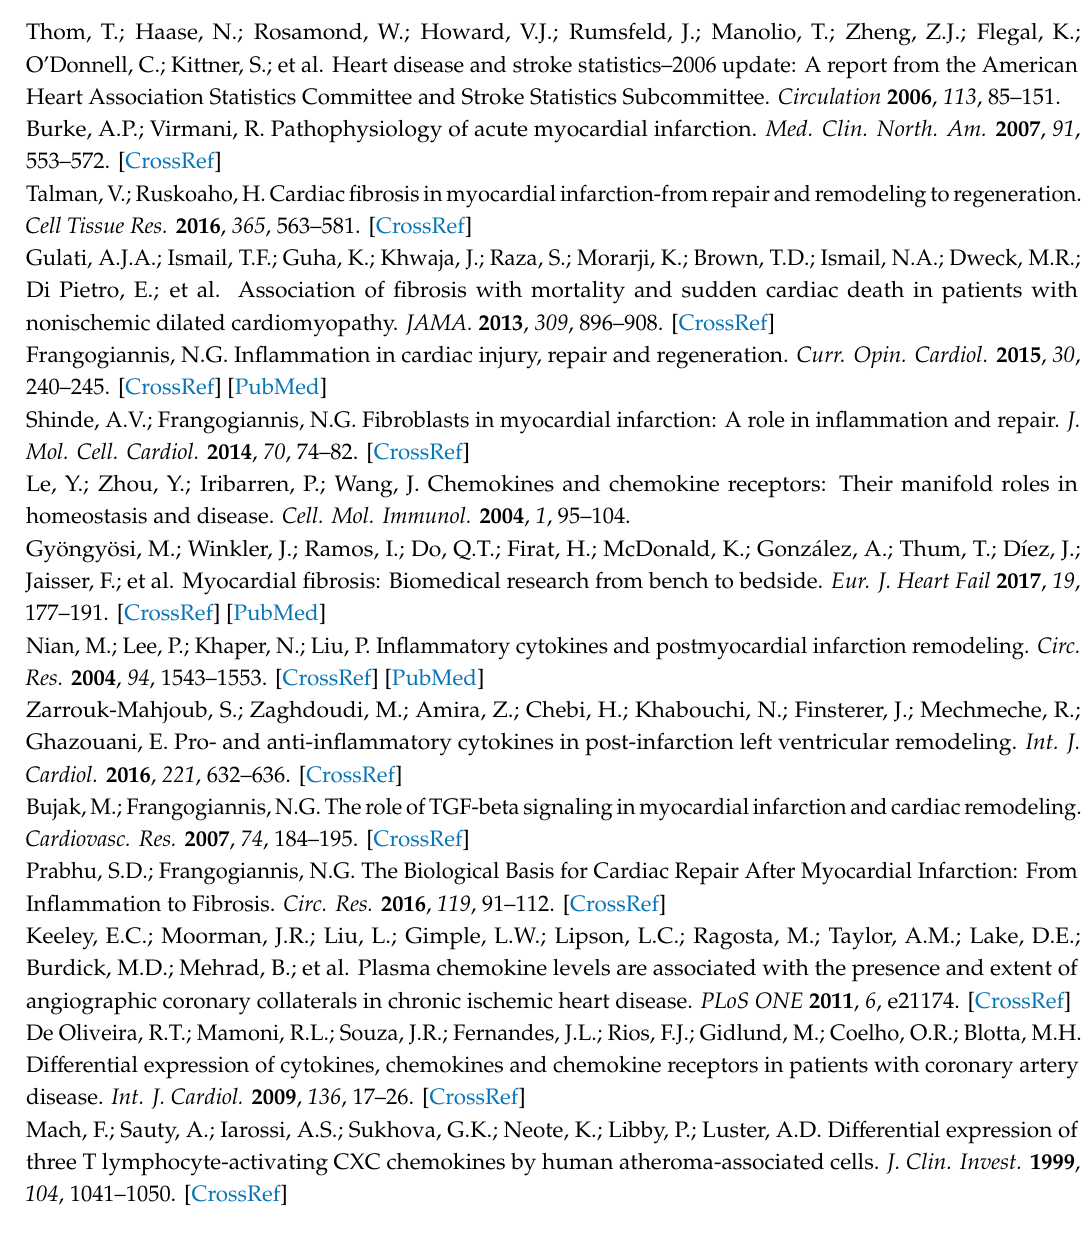
Table S1: title, Maximal blood levels of CK, CKMB, and Troponin-I in patients with